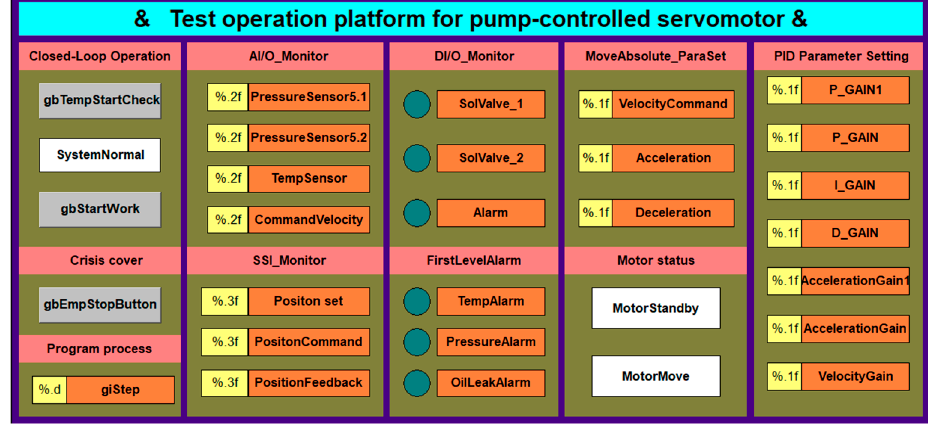
Figure 5. Test platform of PCSM. The axis controller MACS software (here refers to Moog Axis Control Software) was used to compile the monitoring and data acquisition interface of the PCSM experiment platform based on codesys (here refers to Controlled Development System), as shown in Figure 6.